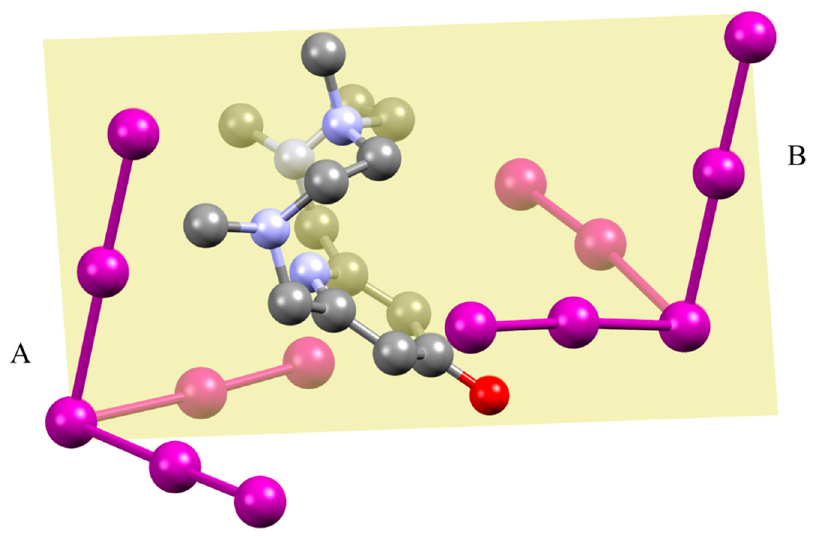
Figure 7. Depiction of the asymmetric unit of the [H 2 L2–Me 3 (I 7 ) 2 ] crystals. All ions are halved by a crystallographic plane (in yellow) and have been here completed for simplicity. Non-equivalent heptaiodide anions are marked as A or B for reference. Color code: grey, C; cyan, N; red, O; violet, I.